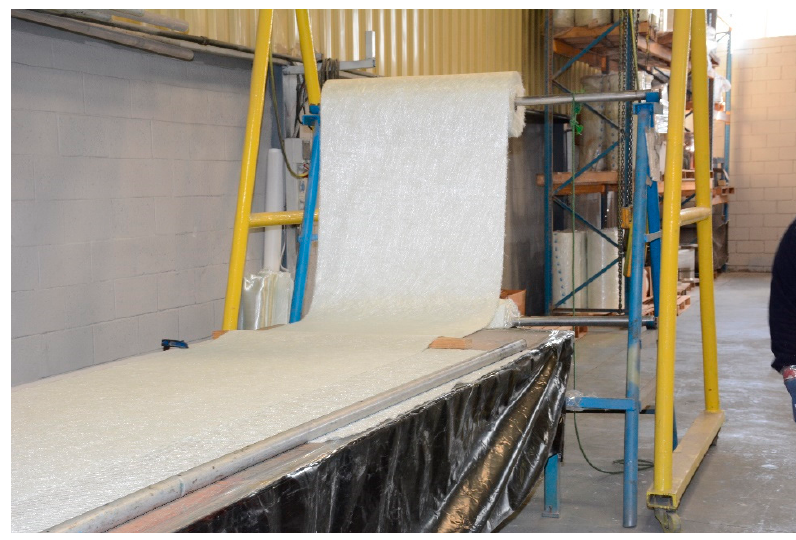
Figure 1. The manufacturing process of a glass fiber sheet.